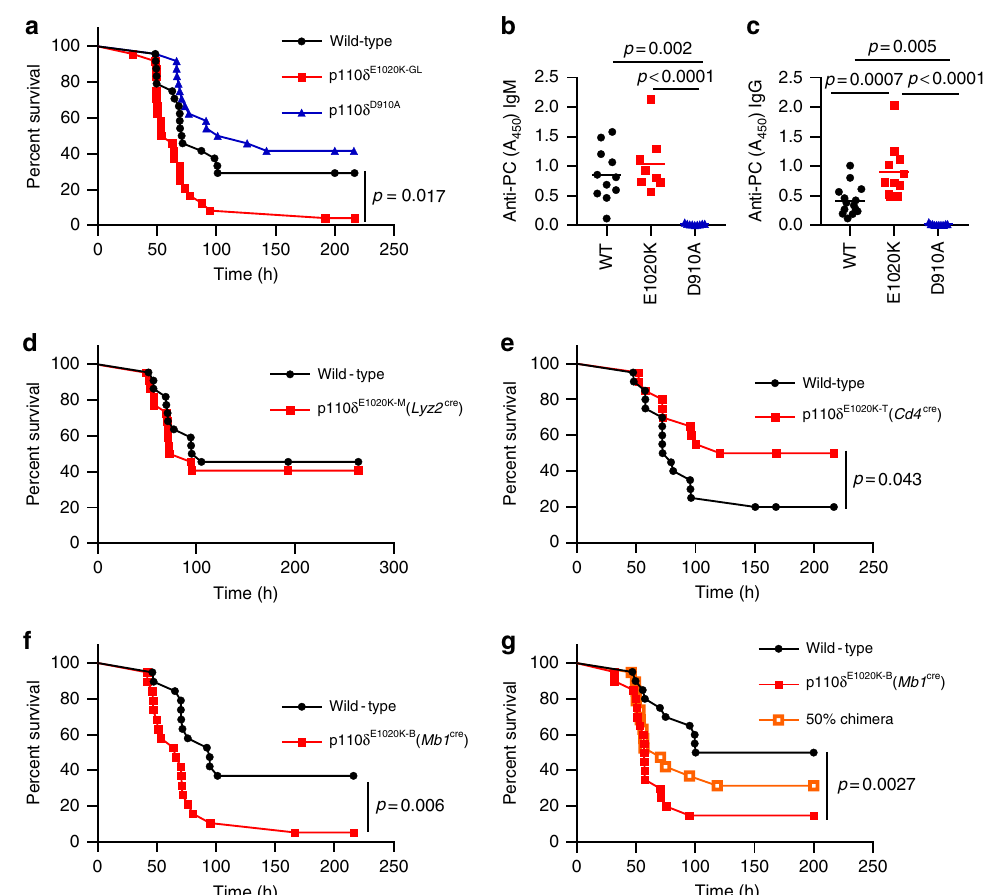
Fig. 4 PI3K δ hyper-activation leads to increased susceptibility to S. pneumoniae infection. a Germline p110 δ E1020K-GL mice show accelerated disease development and signi fi cantly increased mortality compared to control mice in response S. pneumoniae infection, while kinase dead p110 δ D910A mice do not respond differently to wild-type mice. b – c Naïve PI3K δ E1020K mice produce normal levels of anti-phosphorylcholine IgM and signi fi cantly higher levels of anti-PC IgG, while PI3K δ D910A mice produce no natural antibody. d – f The p110 δ E1020K mutation was introduced conditionally into myeloid cells, T cells and B cells by crossing onto Lyz2 cre , Cd4 cre and Mb1 cre lines respectively. The myeloid conditional mutation did not affect survival following S. pneumoniae infection in p110 δ E1020K-M mice ( d ), while T cell conditional p110 δ hyper-activation led to improved survival in p110 δ E1020K-T mice ( e ). Introducing the p110 δ E1020K mutation speci fi cally in B cells (p110 δ E1020K-B mice) replicated the increased susceptibility to S. pneumoniae seen in p110 δ E1020K-GL mice ( f ). g Transfer of p110 δ E1020K-B bone marrow into irradiated RAG2 − / − recipients also conferred increased susceptibility to S. pneumoniae infection compared to recipients receiving wild-type bone marrow, and this phenotype was not fully rescued in a 50% BM chimera. (Data-points represent individual animals; data from 2 independent experiments combined. a n = 24; b , c mean antibody levels shown, WT n = 11, E1020K n = 8, D901A n = 9; d n = 22; e n = 20; f n = 20; g n =